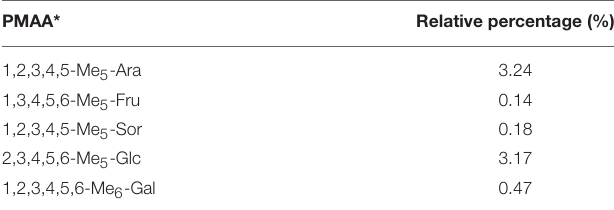
FIGURE 3 | CD spectra of Congo red complex with